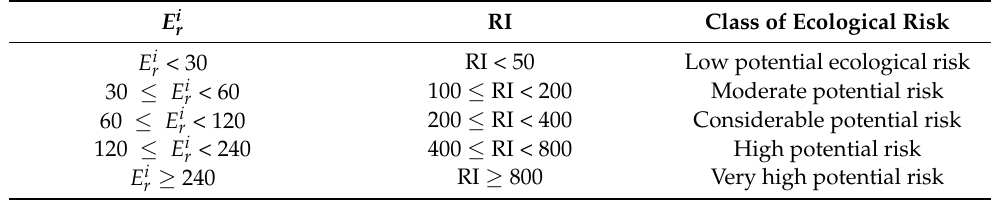
Table 1. Classification of potential ecological risk.